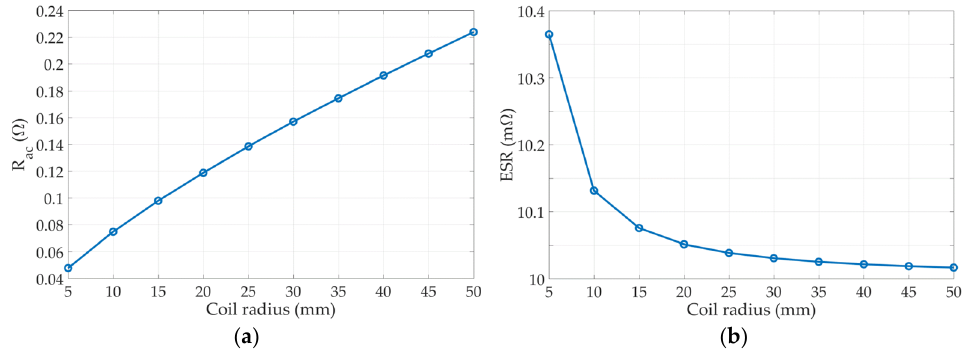
Figure 14. ( a ) Resistance in AC for the helical coil and ( b ) equivalent series resistance (ESR) for the capacitor.